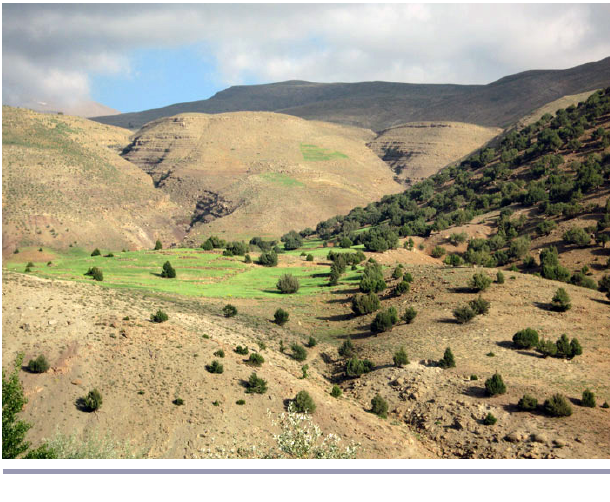
Fig. 6 . Complementary resources of landscape patchiness (photography by Laurent Auclair).